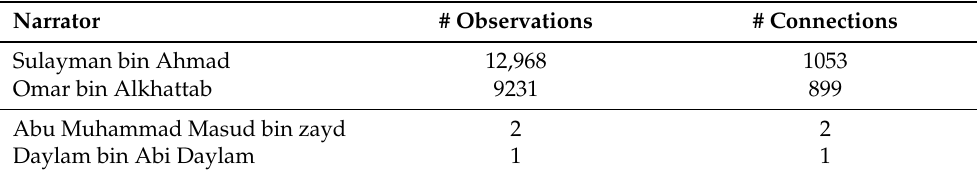
Table 1. Narrators with high or low observations in the AR-Sanad 280K dataset and the number of connections they have (i.e., number of narrators they narrated to/from).